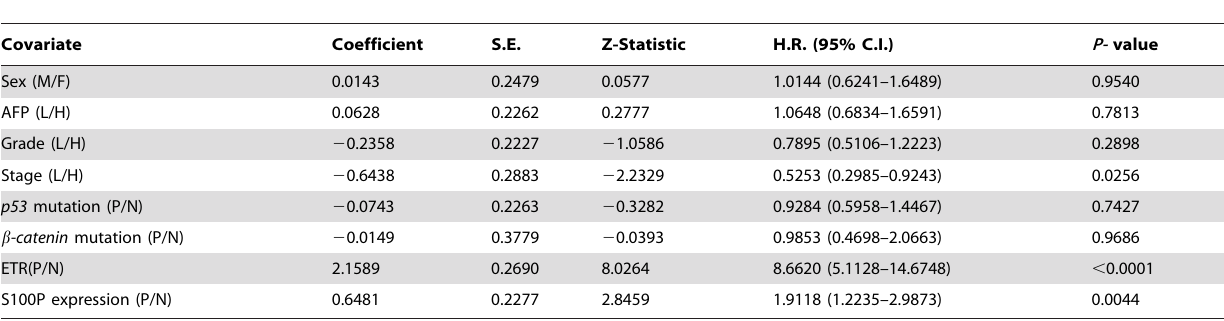
Table 3. Multivariate analyses of prognostic factors in hepatocellular carcinoma patients.